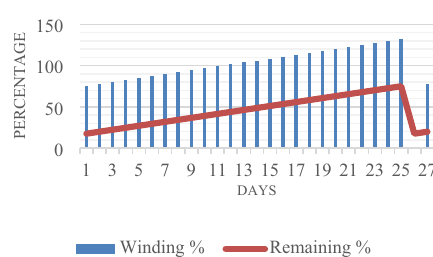
Fig. 8 Percentage of the winding and remaining ratios for 27